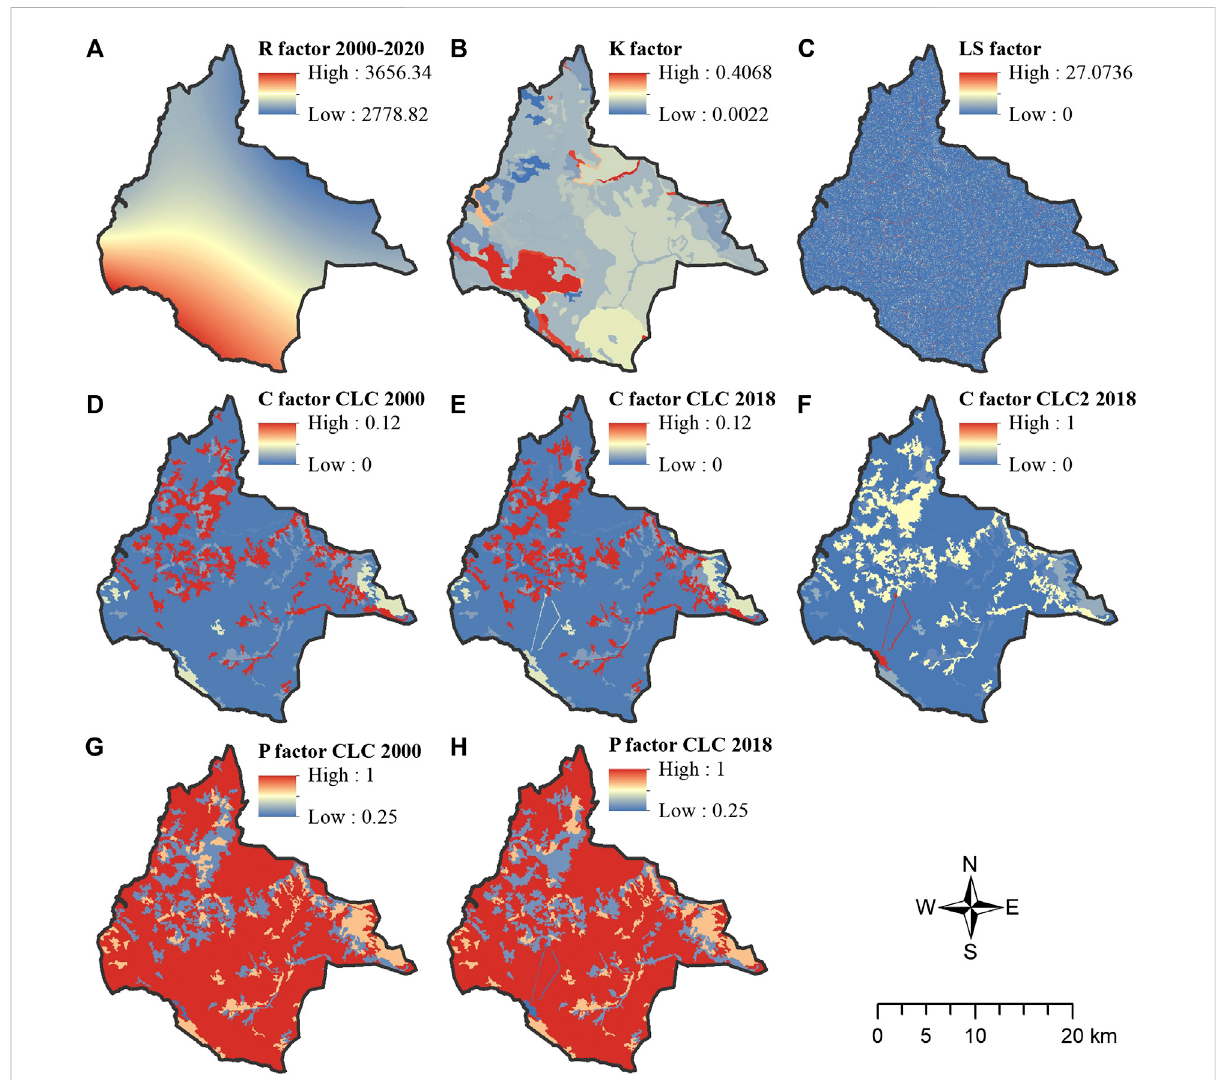
FIGURE 2 Spatial distribution of (A) rainfall erosivity factor, (B) soil erodibility factor, (C) slope length and slope steepness factor, (D) land-use factor CLC 2000, (E) land-usefactorCLC2018, (F) land-usefactorCLC2018v2, (G) conservationpracticefactorCLC2000,and (H) conservationpracticefactor CLC 2018 in the study